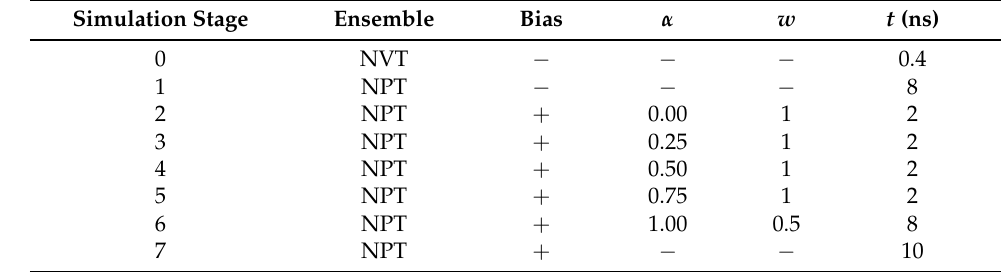
Table 6. Parameters used in MD simulation for each walker. Temperature T is 300 K, except in stage 0 where it is step-wise increased from 0 to 300 K during the first 0.2 ns. We work in the NpT ensemble with the pressure p kept constant at 1 bar. Wherever the values of α and w are reported, these numbers are used to implement Equation (3) of Ref. [22]. The bias used at the each stage (when + symbol is present) is obtained as a combination of the biases coming from all the walkers determined in the previous stage. In the last stage (7) the bias is no more updated with deposited gaussian functions. Sampling performed in stage 7 for all walkers provides the metastatistics that will be finally used to compute thermal